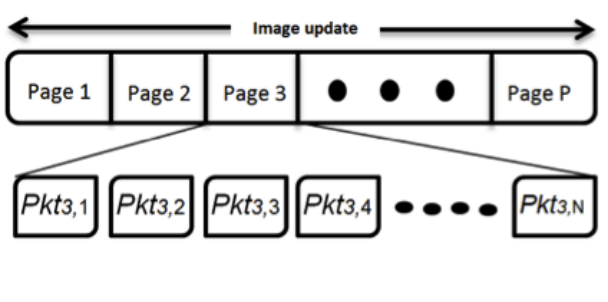
Figure 6. Seluge++ code